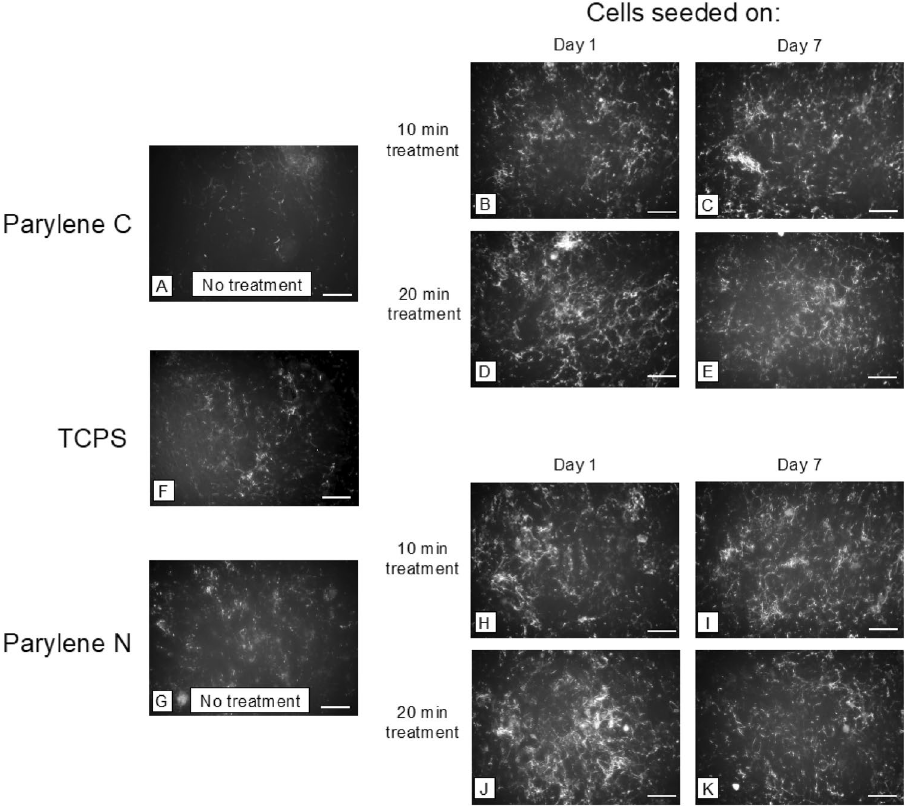
Figure 5. Representative images of Collagen IV deposition by vascular endothelial cells (HUVECs) on ( A–E ) Parylene C membranes, ( F ) TCPS, and ( G–K ) Parylene N membranes. Scale bar = 100 μm in all